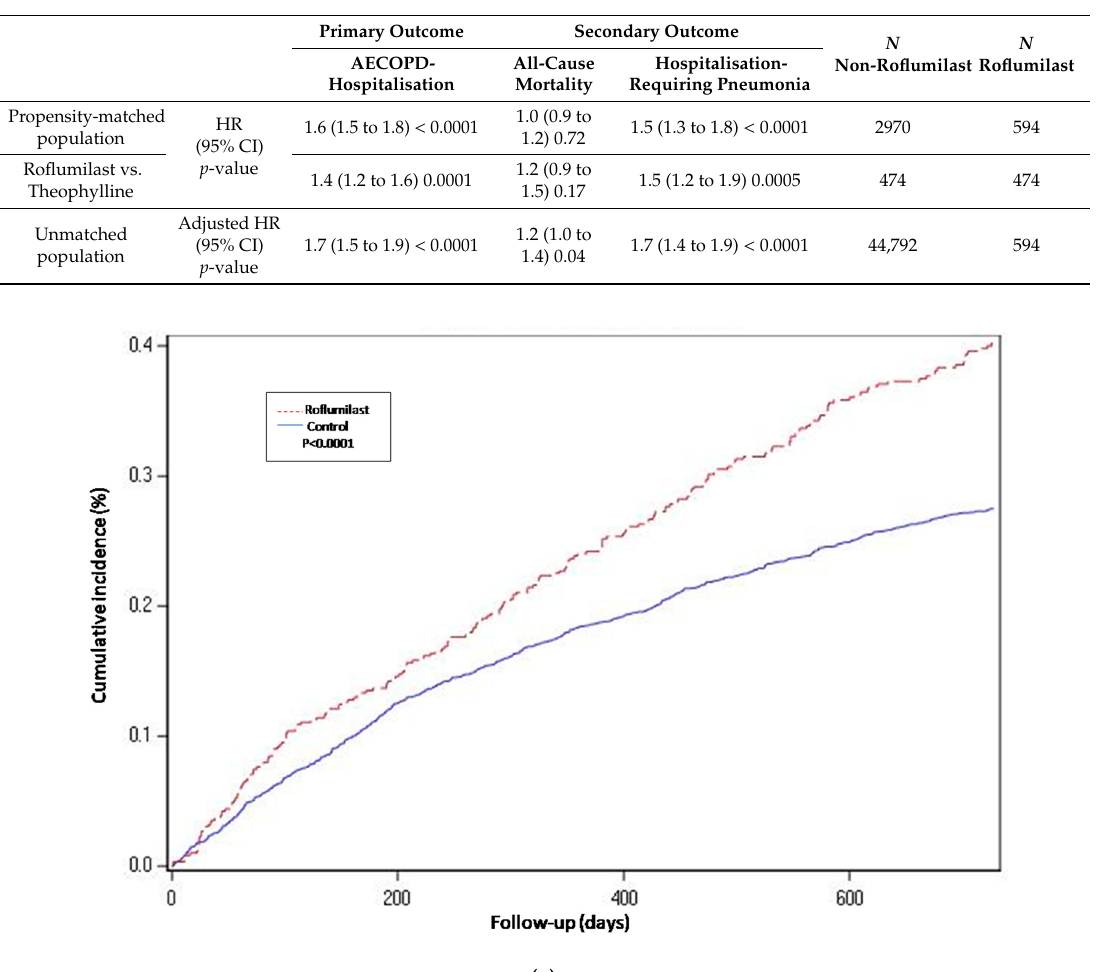
N Non-Roflumilast